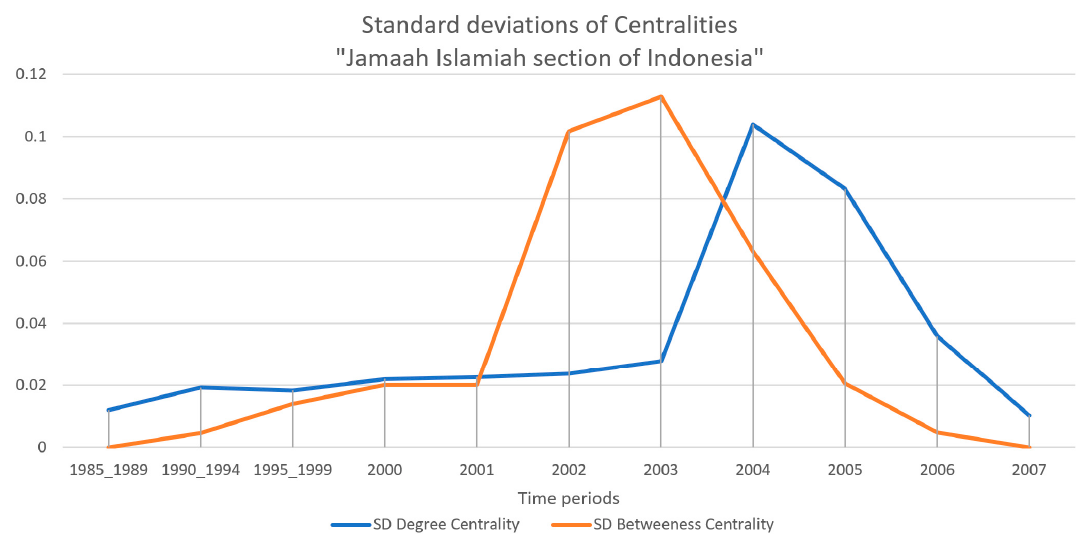
Figure 17. Temporal development of the standard deviation of degree centrality and the standard deviation of betweenness centrality for the “Jamaah Islamiah section of Indonesia”. Both indices increase, reach a maximum and then decrease. The average degree centrality reaches a maximum in 2004, while the average betweenness centrality does so in 2003.